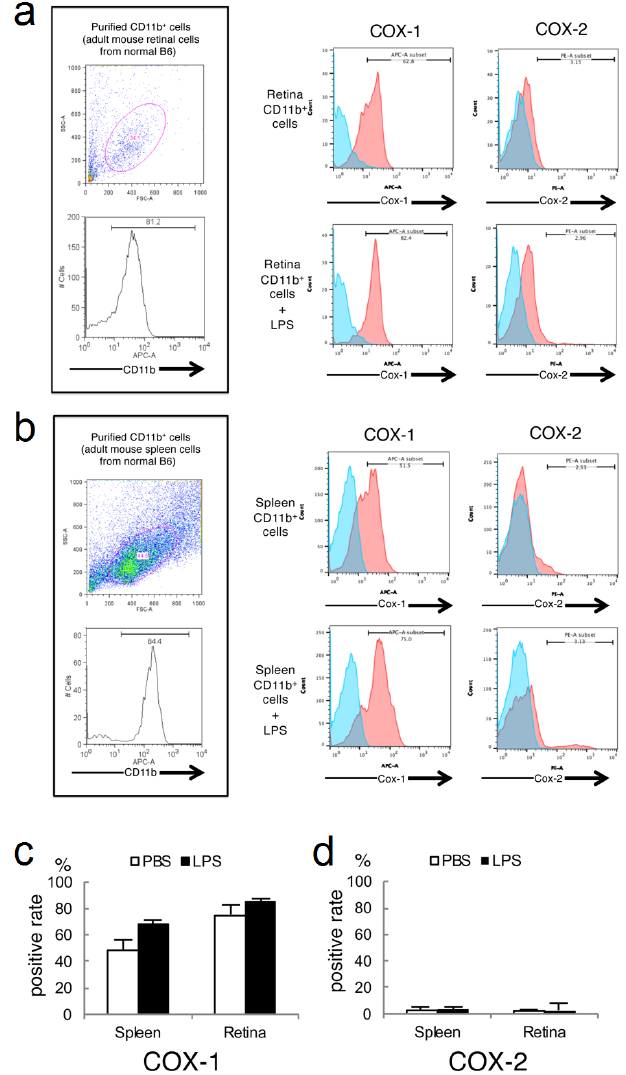
Figure 3. In vitro analysis of the expression of COX-1 and COX-2 in retinal microglia/macrophage and splenic macrophage. ( a ) Cultured retinal glia cells of C57BL/6J mice were stained with anti-CD11b, anti-COX-1, and anti-COX2. A FACS cytometric analysis was performed 72 h after PBS- (upper) or LPS- (lower) administration. Red plots show the results of COX-1 or COX-2 positivity. Blue plots show the results of isotype control. Numbers (%) in the histogram indicate the ratio of positive cells. Thresholds were set by the staining with isotype control of the antibody. ( b ) Cultured splenic cells of C57BL/6J mice were stained with anti-CD11b, anti-COX-1, and anti-COX2. PBS- (upper) or LPS- (lower) administrated samples were analyzed on a FACS flow cytometer. Red plots show the results of COX-1 or COX-2 positivity. Blue plots show the results of isotype control. Numbers (%) in the histogram indicate the ratio of positive cells. Thresholds were set by the staining with isotype control of the antibody. ( c ) A graph showing the positive rate of COX-1 in splenic macrophages and retinal microglia/macrophage after administration of PBS (white bar) or LPS (black bar). An error bar showing standard deviation (SD). ( n = 3). ( d ) A graph showing the positive rate of COX-2 in splenic macrophages and retinal microglia/macrophage after administration of PBS or LPS. Error bar shows SD. ( n = 3). 2.4. Analysis of CD45 and COX-1 Expression in CD11b-Positive Cells Collected from the CNS The CD11b/COX-1 positive cells in the retina could be either microglia or